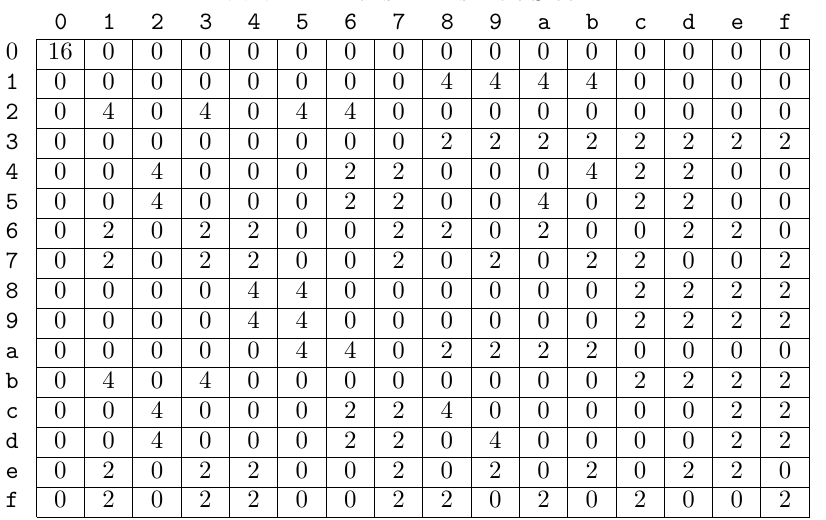
Table 2: DDT of SKINNY ’s 4-bit S-box